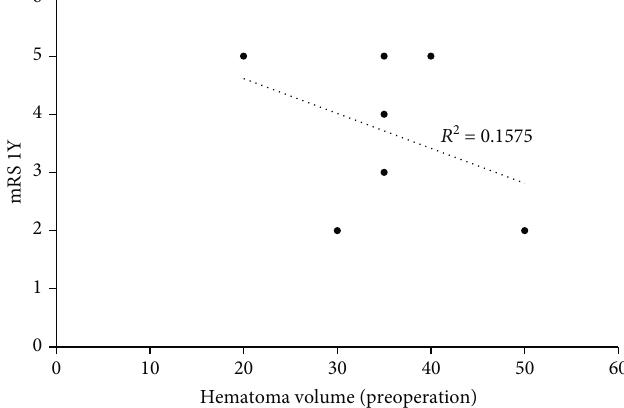
Figure 2: Correlation analysis of 1-year mRS and preoperative hematoma volume.